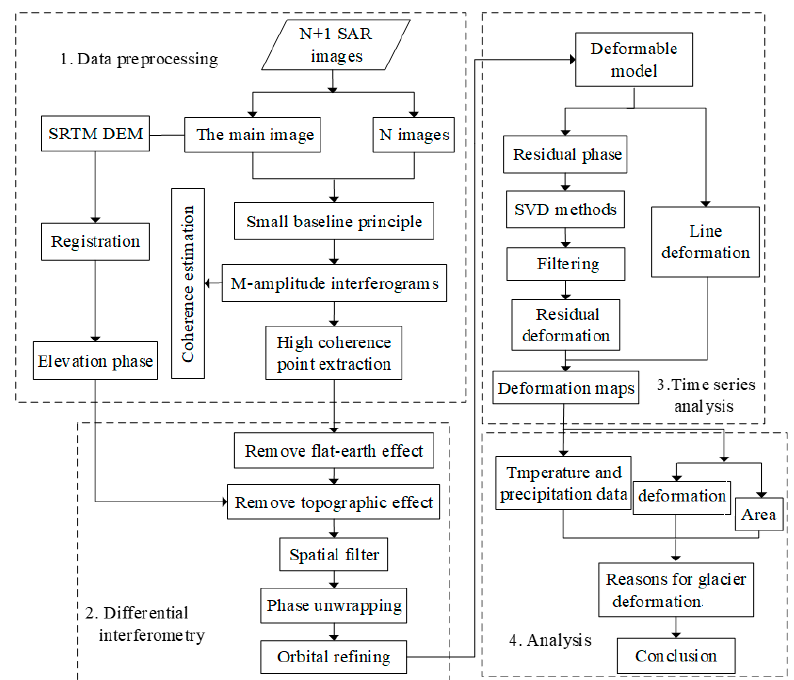
Figure 4. Flowchart showing the processing steps of the Small Baseline Subsets (SBAS) Interferometric Synthetic-Aperture Radar (InSAR) method used in this study. Singular Value Decomposition (SVD) is a method for mosaicking interferograms.